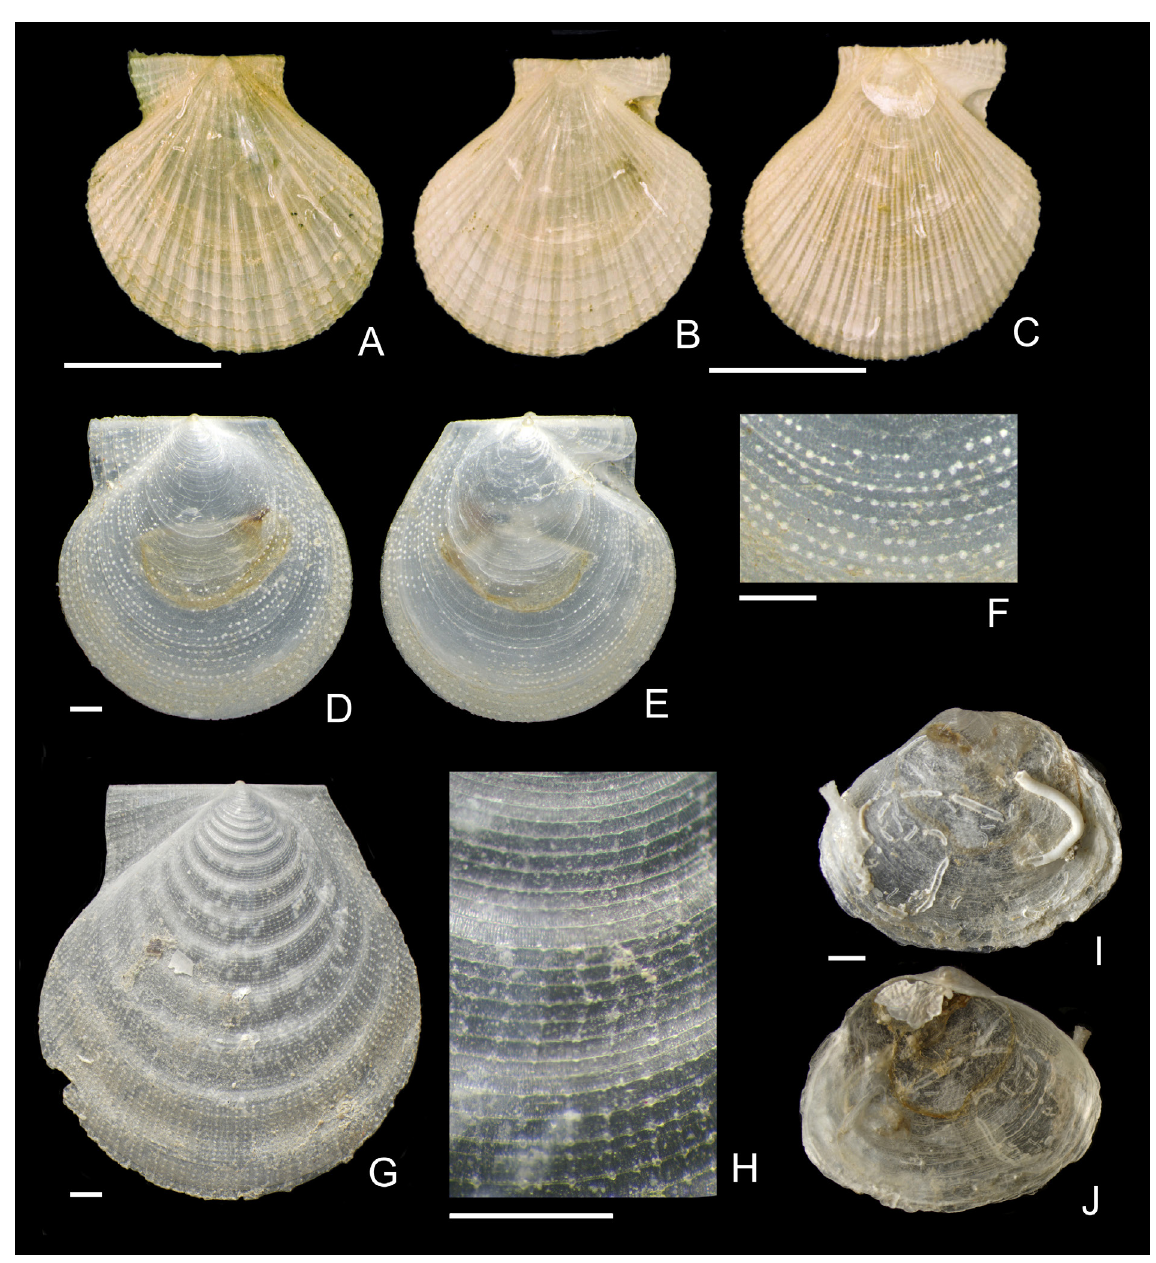
Fig. 36. Pectinidae, Anomiidae. A–C . Pseudamussium sulcatum (Müller, 1776) , SEAMOUNT 1, DW116, 985–1000 m, 19.1 and 20.1 mm. D–F . Delectopecten vitreus (Gmelin, 1791), BANGAL 0711, GOC3, 785 m, 9.5 mm, and detail of the sculpture of the right valve. G–H . Hyalopecten pudicus (E.A. Smith, 1885), right valve, BANGAL 0711, DR15, 1410 m, height 13.2 mm, and detail of the sculpture. I–J . Heteranomia squamula (Linnaeus, 1758), SEAMOUNT 1, DW106, 765 m, 8.0 mm. Scale bars: A–C = 10 mm; D–J = 1